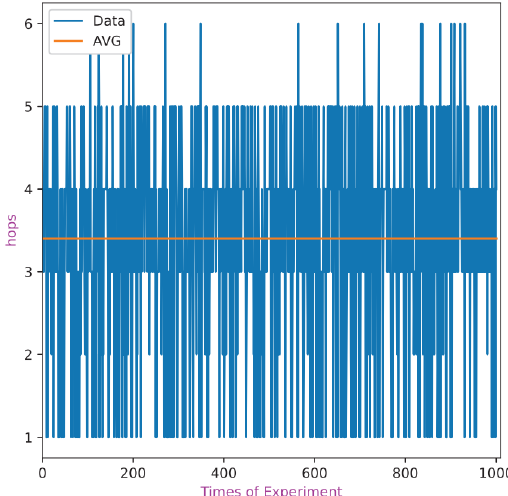
Figure 7. The statistic result of query efficiency. Table 2. The statistic result of experiment 2.